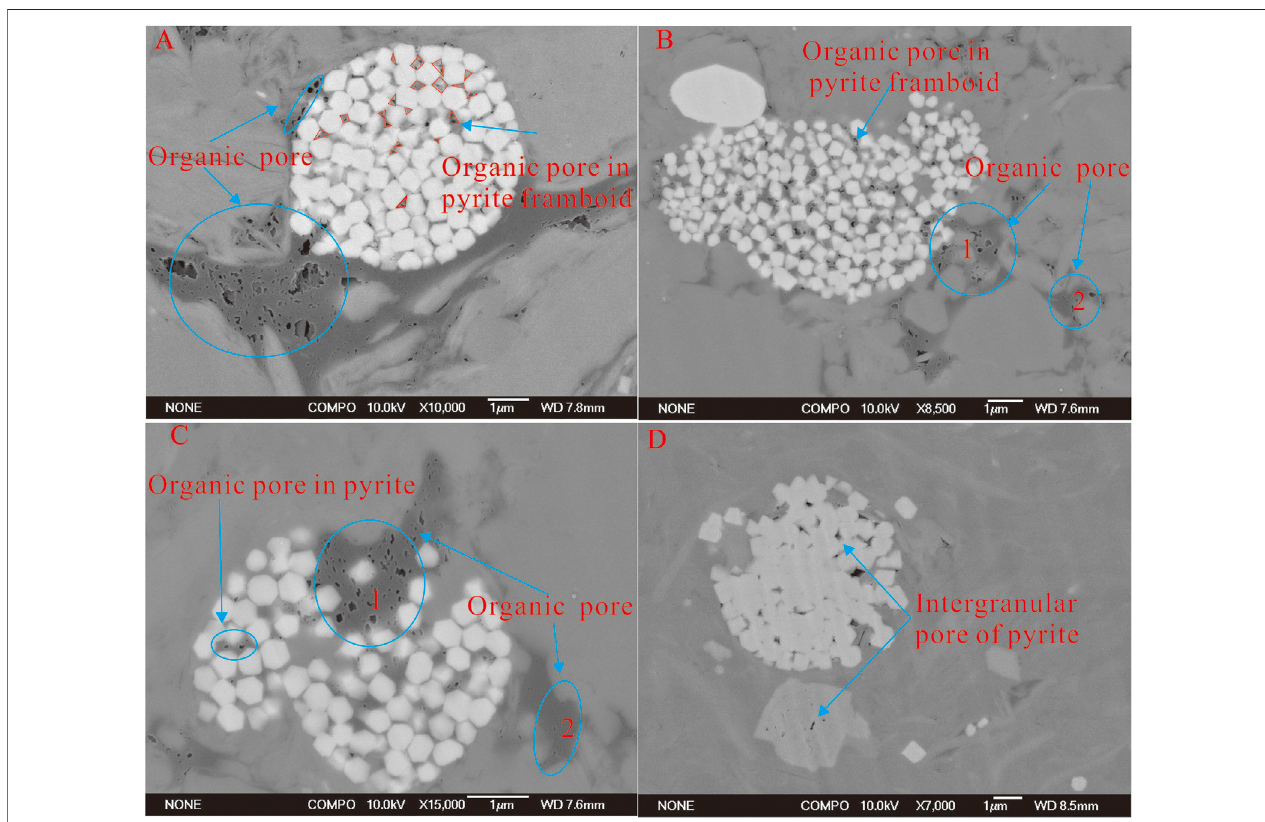
FIGURE 3 | Common pore types associated with pyrite in the Longmaxi Formation shale in the southeastern basin. (A) Organic pore in pyrite framboid, X2 well, 2376.05 m; (B) organic pore in pyrite framboid, X2 well, 2385.42 m; (C) organic pore in pyrite framboid, X2 well, 2385.42 m; (D) intergranular pore of pyrite, X2 well, 2335.30 m.